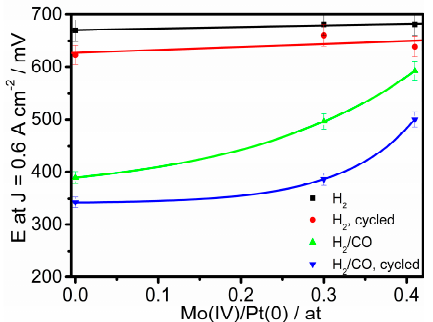
Figure 5. Polarization curves of the catalysts annealed at 600 ◦ C supplied in the anode with H 2 (closed symbols) at 105 ◦ C, 2 atm and 150 cm 3 min − 1 and H 2 /100 ppm CO (open symbols), on the cathode was used Pt/C at 90 ◦ C, 1.75 atm and 100 cm 3 min − 1 , the temperature of the cell was 85 ◦ C, before ( a , b ) after accelerated aging testes.